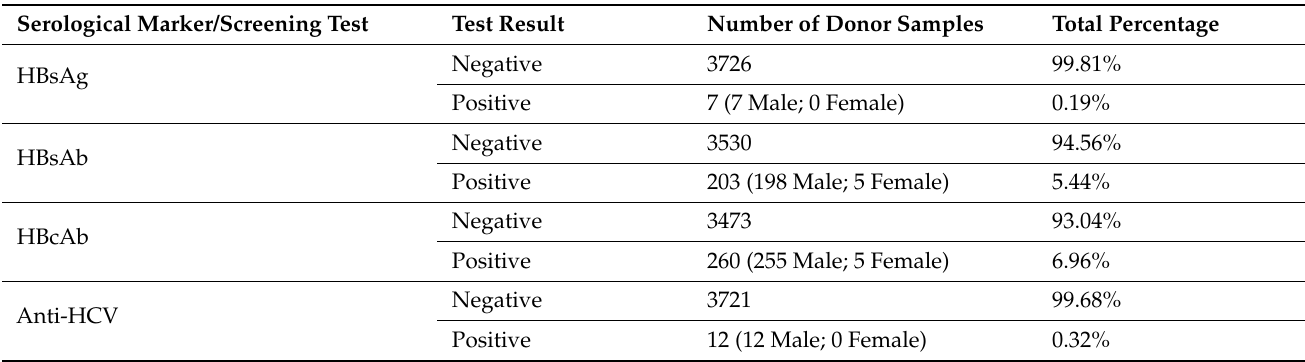
Table 2. The prevalence of HBV and HCV serological markers in the blood samples of donors.